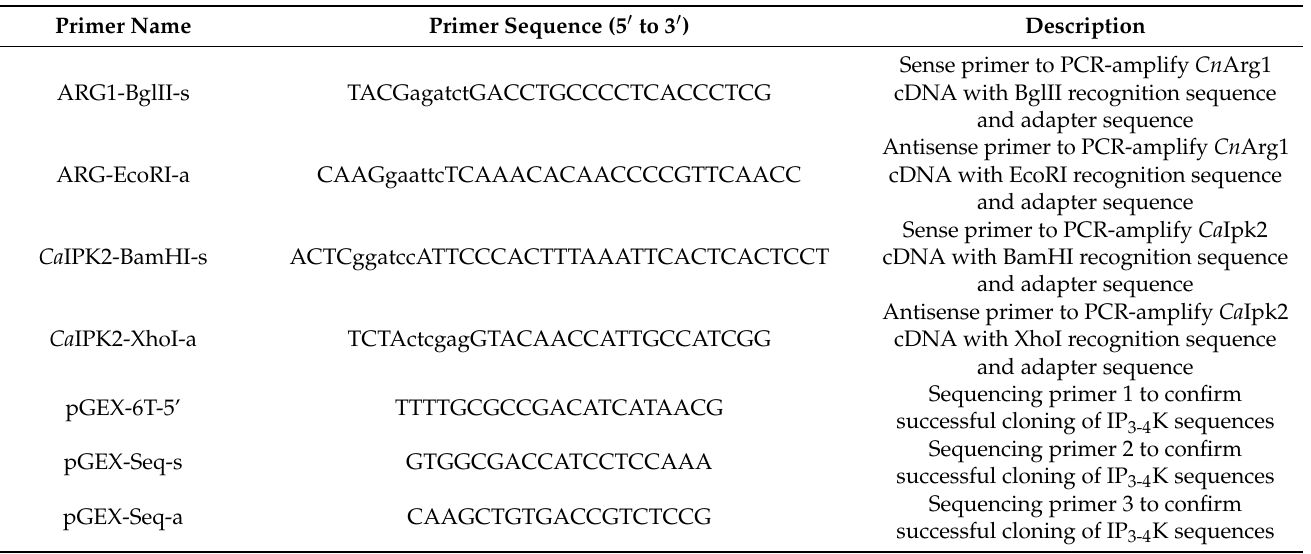
Table 1. Primers used to construct and verify expression